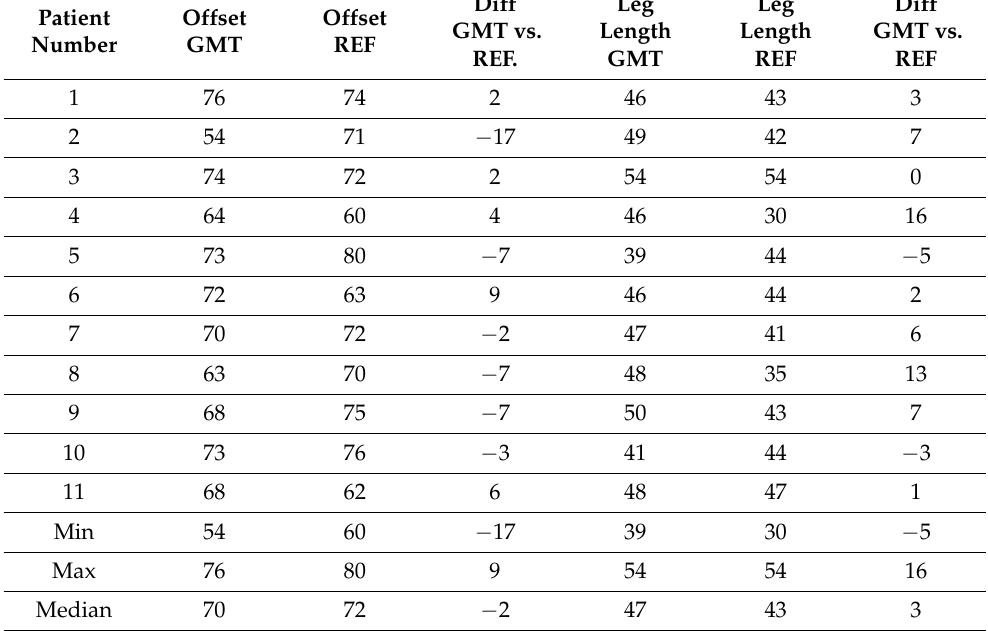
Table 1. The total postoperative offset and leg length of 11 patients included in the study. The calculated difference between the offset and the leg length measurement of the gluteus maximus transfer (GMT) side and the contralateral side (REF) is presented in millimetres